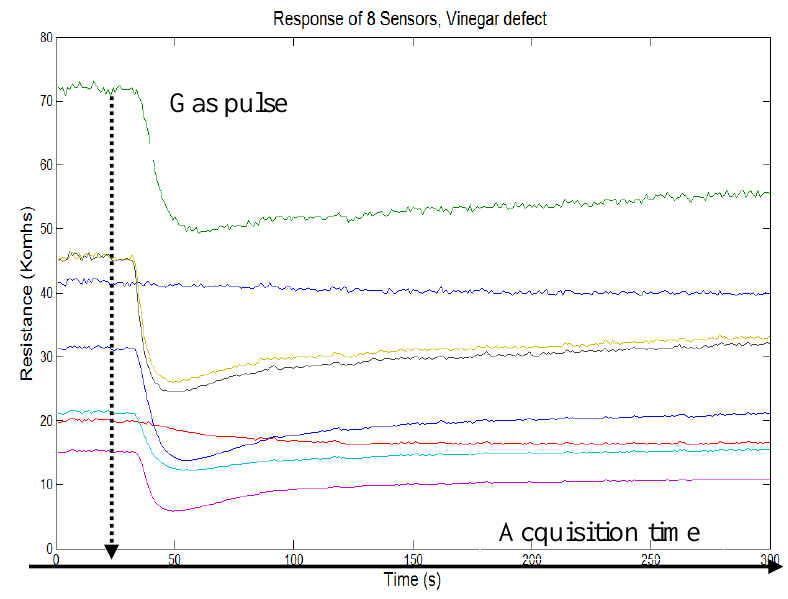
Figure 6. Sensor array response for vinegar coffee.